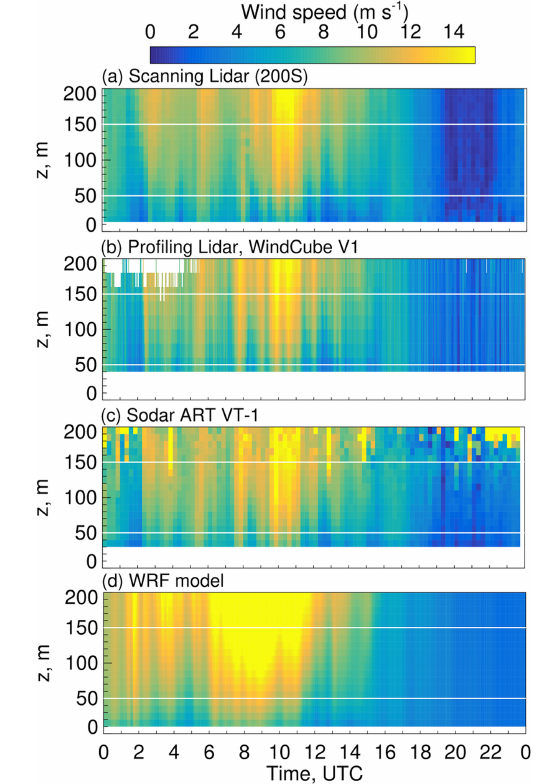
Figure 8. Observed wind speeds up to 200m above ground as a function of time from the (a) scanning Doppler lidar (200S), (b) the profiling lidar (Wind Cube, V1), (c) the sodar (ART VT1), and (d) simulated wind speeds at Wasco on 24 September 2016. Two horizontal white lines in each panel indicate the 50–150m layer where turbines